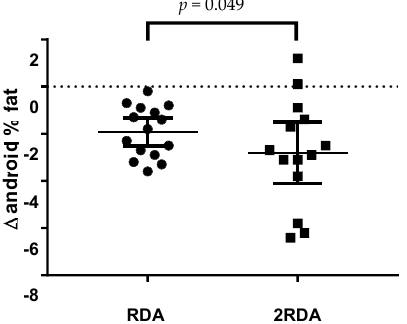
Figure 3. Change in android % fat from before to after 10 weeks of consuming the RDA (circles) and 2RDA (squares) diets. Each point represents a participant. The central lines represent means and the error bars represent SD. ∆ , absolute change; Two-way repeated measures ANOVA was used for comparison.